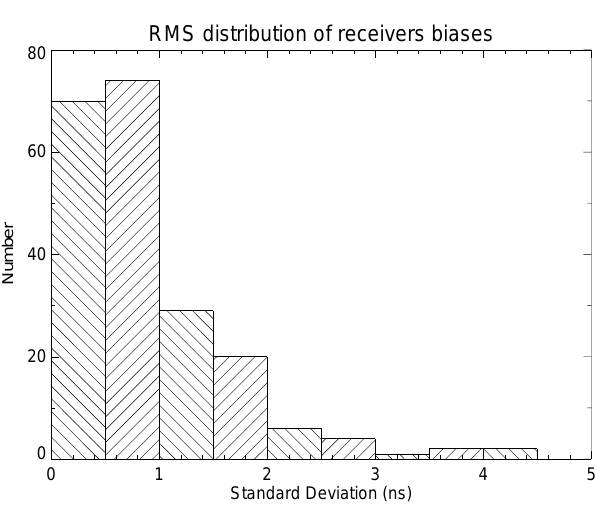
Fig. 5. Latitude variation of the standard deviation of the GEONET derived receiver biases from the 9-day mean. No systematic trend can be